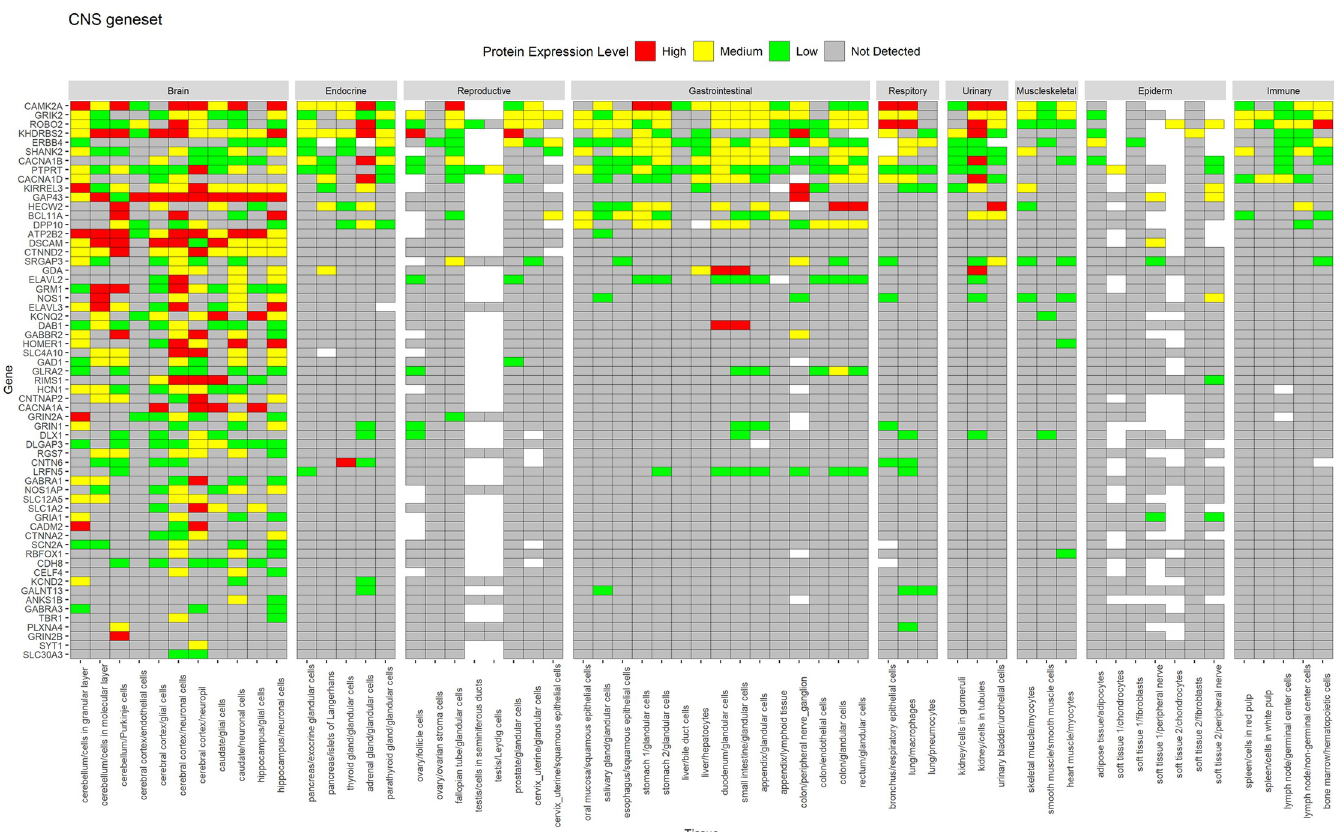
Fig 4. Protein expression of CNS geneset from HPA across tissues. Genes are displayed in order of decreasing protein expression.